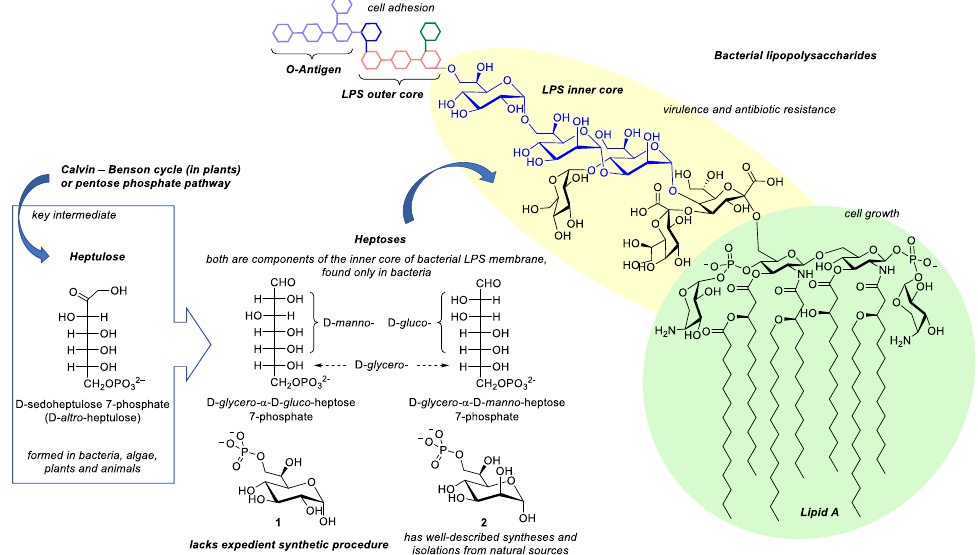
Figure 1. D -glycero- α - D -gluco-heptose and D -glycero- α - D -manno-heptose origin and utilization in the bacterial membrane (generalized LPS structure representation, fatty acids, and heptose epimers may vary in different genera).